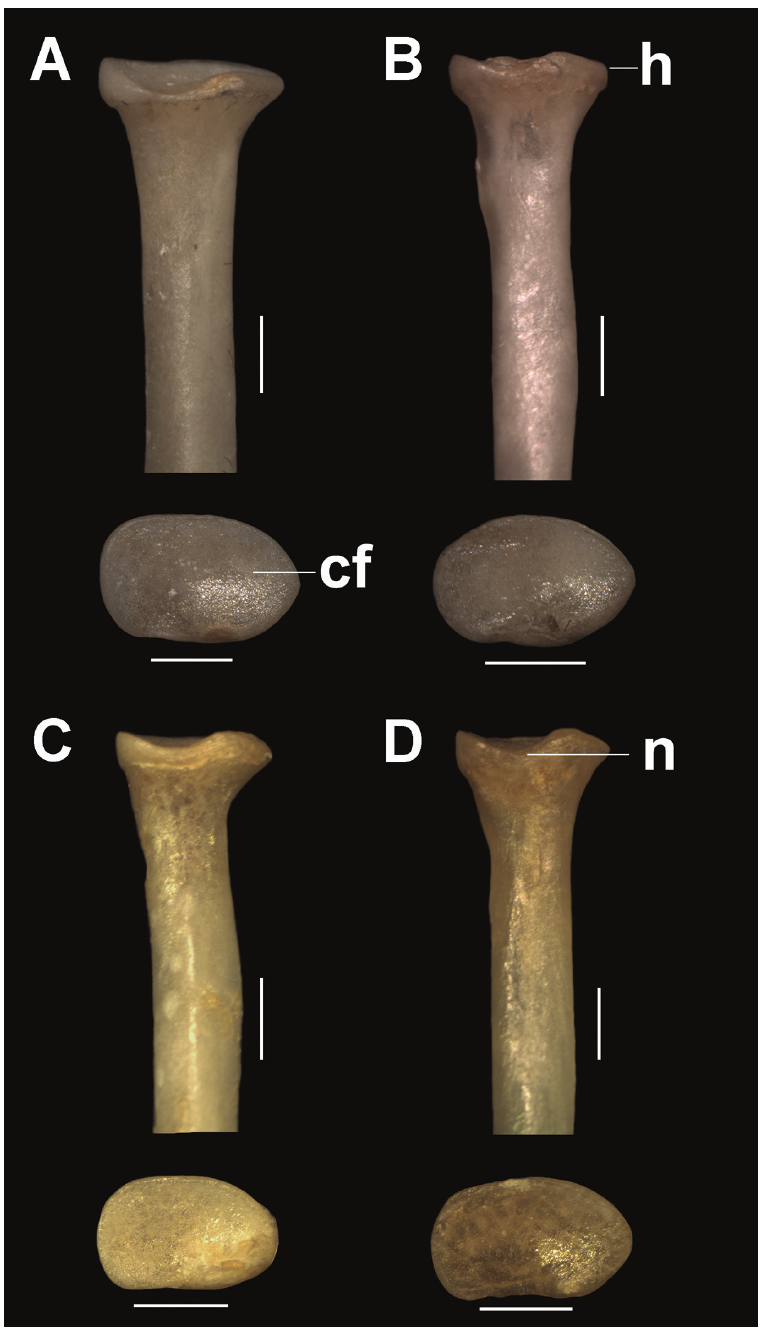
Figure 3. Cranial and proximal views of the proximal portion of the right radio. A Tympanoctomys aureus B Tympanoctomys barrerae C Tympanoctomys kirchnerorum D Tympanoctomys loschalchalerosorum . cf, central fossa; h, head; n, notch. Scale bars